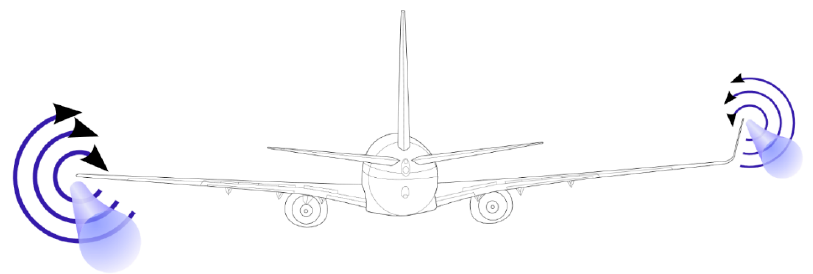
Figure 1. Wingtip vortices with and without winglets. Image source: Olivier Cleynen, Wikimedia Foundation Inc.—Wingtip Device, 2020 [6]. Foundation Inc.—Wingtip Device, 2020 [6]. Foundation Inc.—Wingtip Device, 2020 [6].